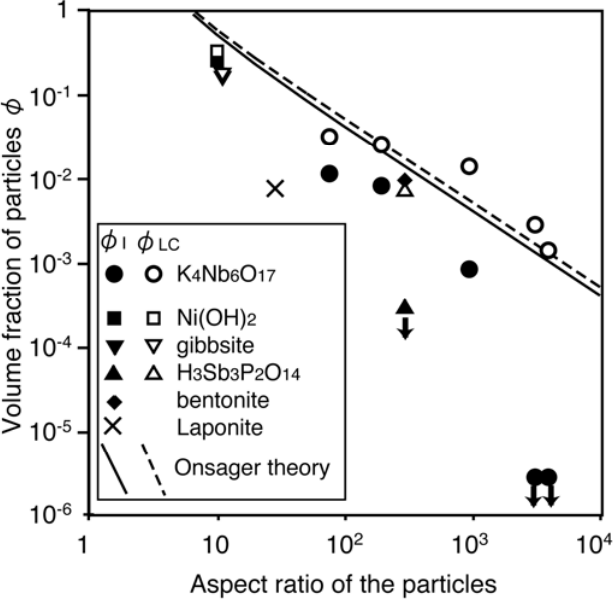
Figure 6. Relationship between aspect (diameter to thickness) ratio of colloidal disks and the transition concentrations φ (isotropic–biphasic) and φ (biphasic–liquid crystalline) I LC observed for the niobate nanosheet colloid with those in the literatures [100]. Solid and dashed lines represent the theoretical values numerically calculated based on the Onsager theory. The down arrows indicate that the transition concentration was not determined but is lower than the value indicated by the symbols. Reprinted with permission from Ref. [100]. Copyright 2004 American Chemical